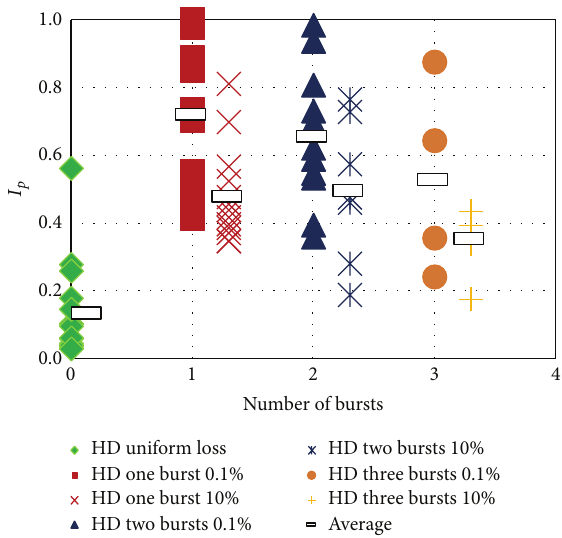
Figure 6: 𝐼 𝑝 versus number of bursts in HD video